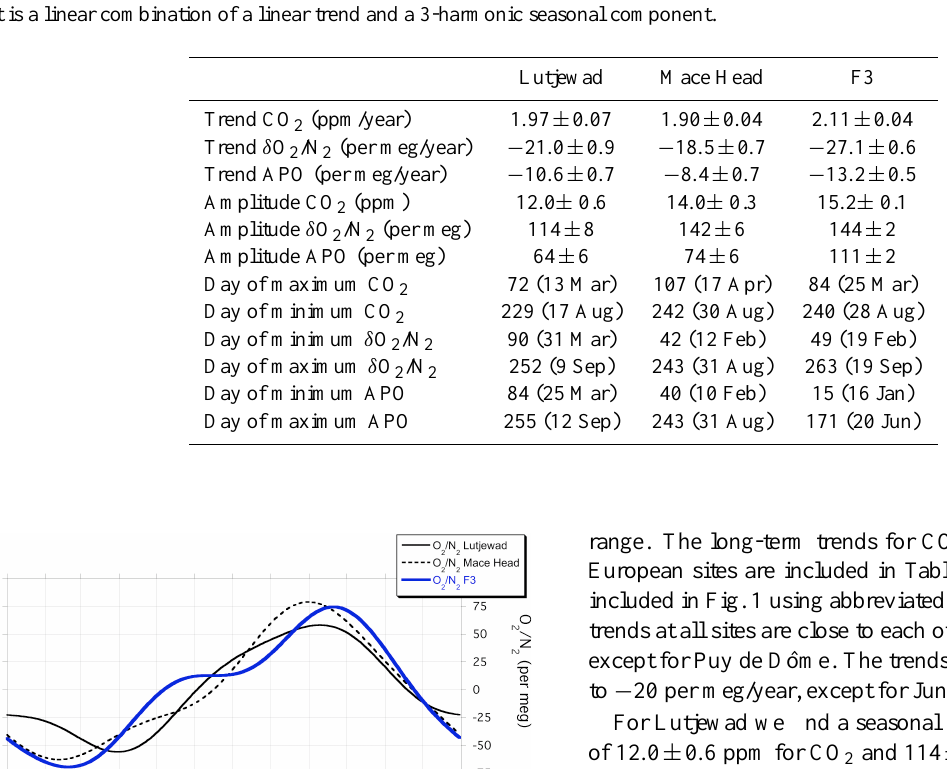
Table 1. CO 2 and O 2 trend and seasonality based on the fit of the data sets from each measurement site: Lutjewad, Mace Head and F3. The used fit is a linear combination of a linear trend and a 3-harmonic seasonal component.